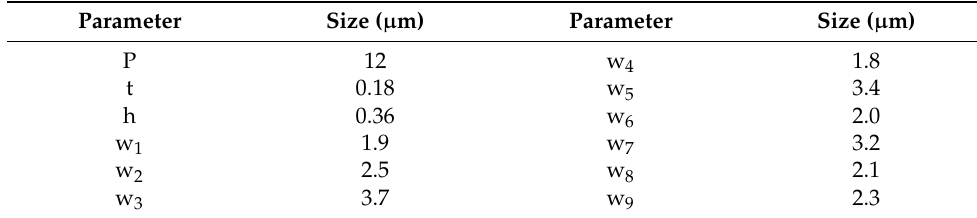
Figure 1. Schematic view of the Au, Al 2 O 3 , Au, SiO 2 , and Au 3 × 3 five-layer unit cell. Table 1. Dimension of the MA structural